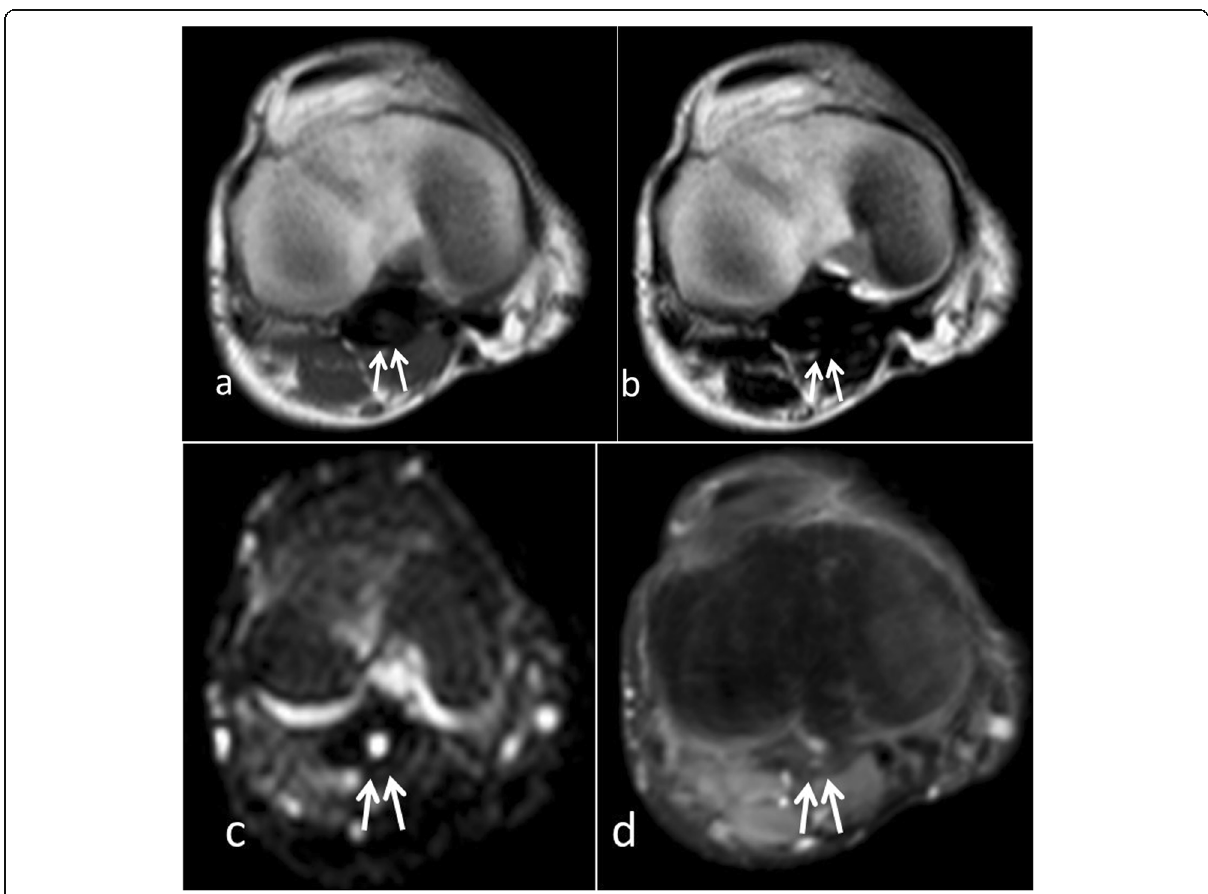
Fig. 5 Popliteal fibromatosis presenting in a 40-year-old male; a axial T1, b axial T2, c axial DWI, d axial post-contrast THRIVE images: the lesion (arrows) showing hypo-intense signal intensity on T1, T2 images, and DWI and virtually no contrast uptake on post-contrast